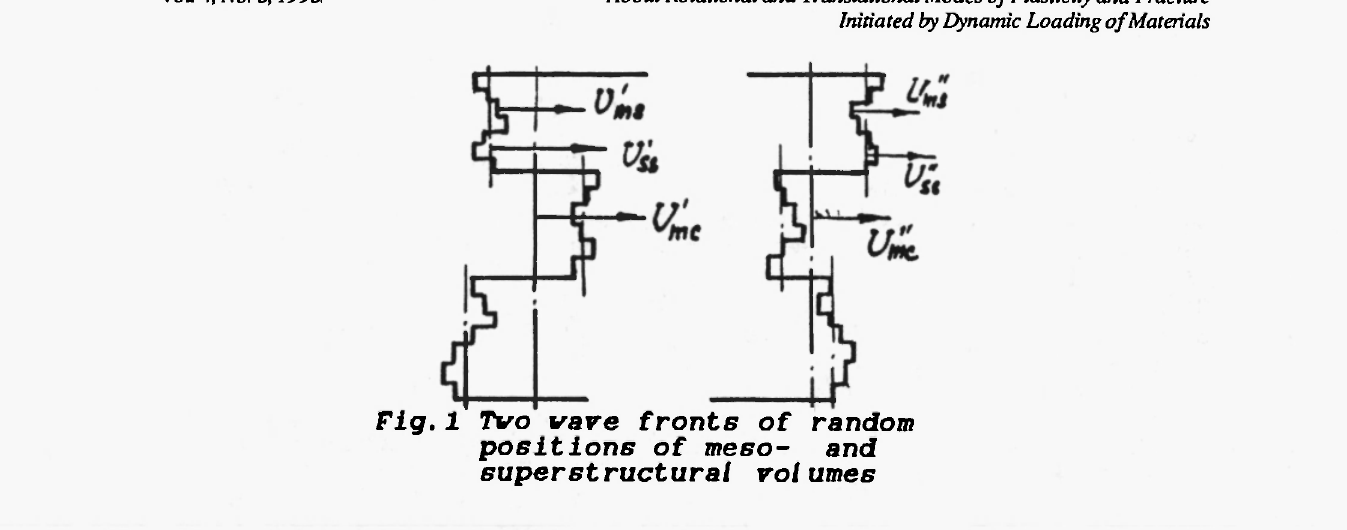
Fig. 1 Two wave fronts of random positions of meso- and super structural